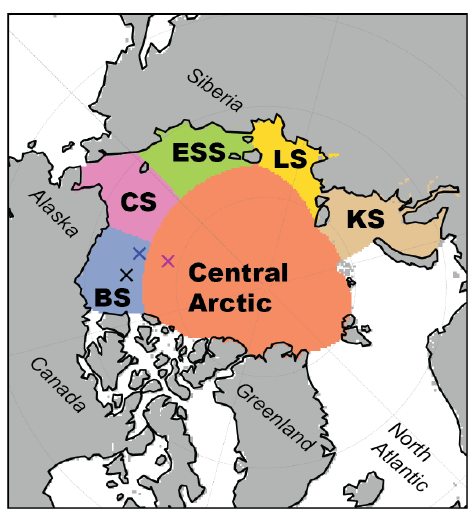
Figure 5. Inner Arctic Ocean study domain, defined as the com- bined area of the Central Arctic, Beaufort Sea (BS), Chukchi Sea (CS), E Siberian Sea (ESS), Laptev Sea (LS) and Kara Sea (KS), adopted from a region mask of the Arctic Ocean from the National Snow and Ice Data Center (NSIDC) provided by Meier and Stewart (2023). The blue, magenta and black crosses mark the location of BGEP moorings A, B and